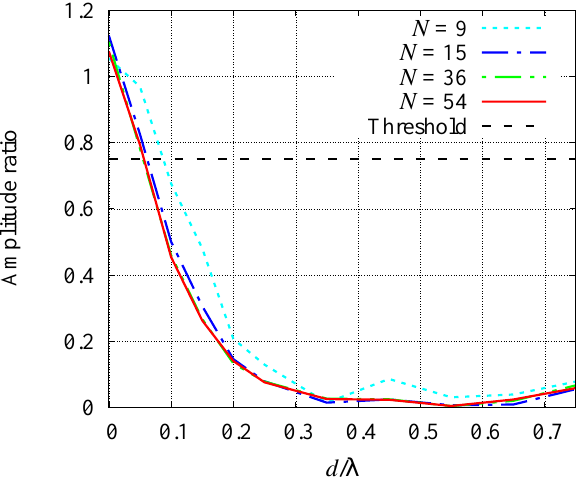
Figure 10. Spatial resolution. The separation distance between the two cylinders is shown on the abscissa, while on the ordinate axis is the ratio between the amplitudes. Light blue line: 9 sensors; blue line: 15 sensors; green line 36 sensors; red line: 54